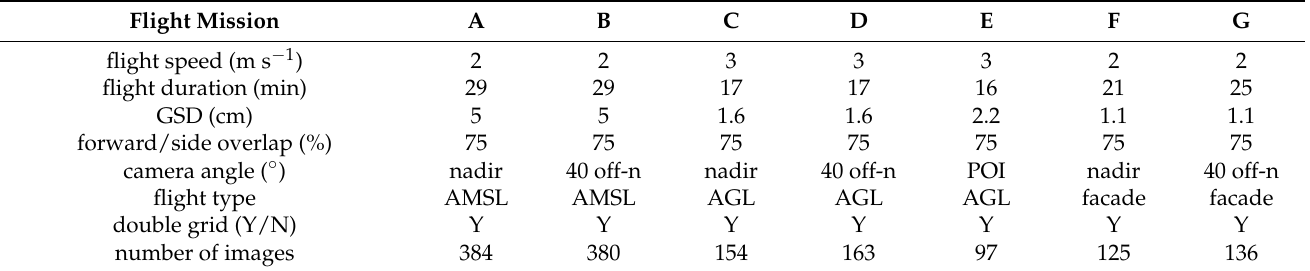
Table 1. Features of the seven conducted flight